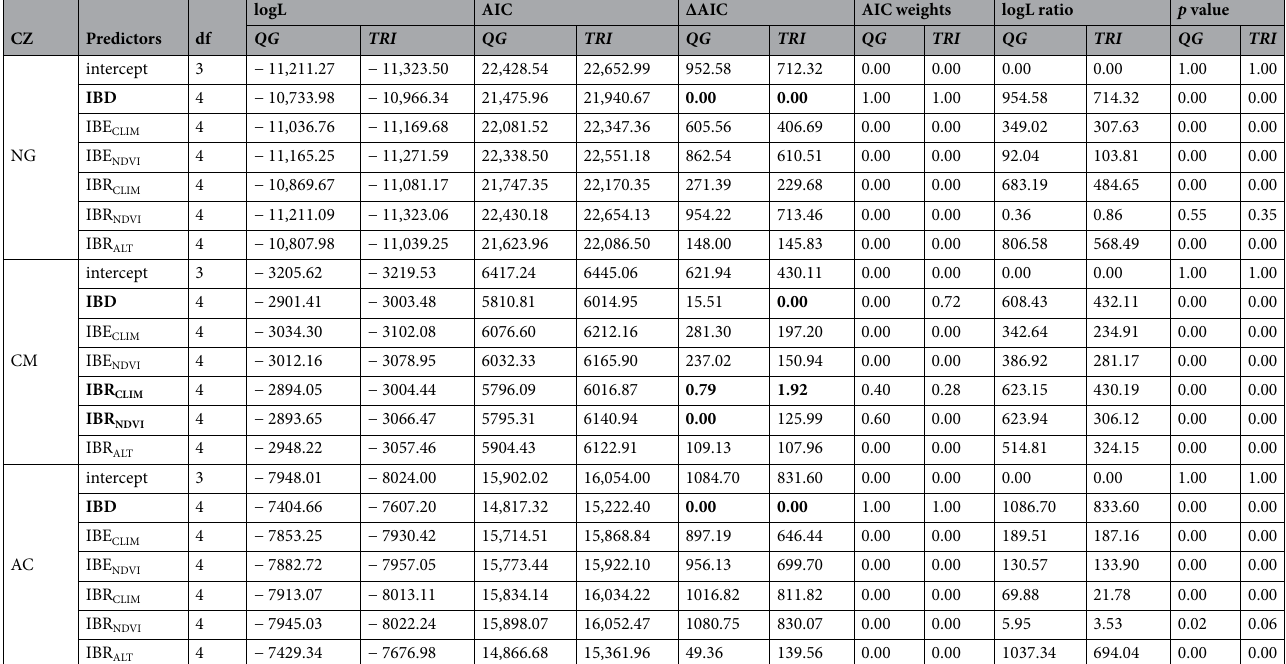
Table 2. Results of the GLS regression with MLPE correlation relating the genetic distance with different models of isolation (IBD, IBE and IBR). Predictors showing at least one best model are highlighted in bold. The log Likelihood (logL) ratio compares each model with an intercept-only model. The AIC differences (∆AIC) is in respect to the best model (lowest AIC) in each combination of genetic distance matrix and contact zone. Models with ΔAIC lower or equal to 2 (best model) are highlighted in